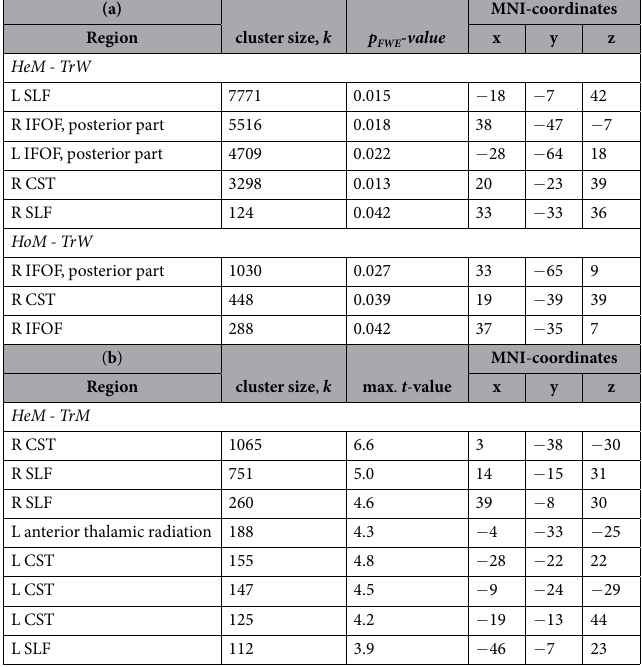
Table 3. Table 3 corresponds with Fig. 2. Part ( a ) shows post-hoc comparisons of a one-way ANOVA (with age as covariate) including heterosexual and homosexual cisgender men (HeM, HoM), and transgender women ( TrW ); results are displayed at p FWE < 0.05, and a minimal cluster size of k ≥ 100 voxel (1 mm 3 voxel size); Part ( b ) shows the resulting clusters of a t -test between HeM and transgender men (TrM) displayed at p FWE < 0.05, cluster threshold of t = 2.3, and minimal cluster size of k ≥ 100 voxel; CST = cortico-spinal tract; SLF = superior longitudinal fasciculus; IFOF = inferior fronto-occipital fasciculus; L = left; R =